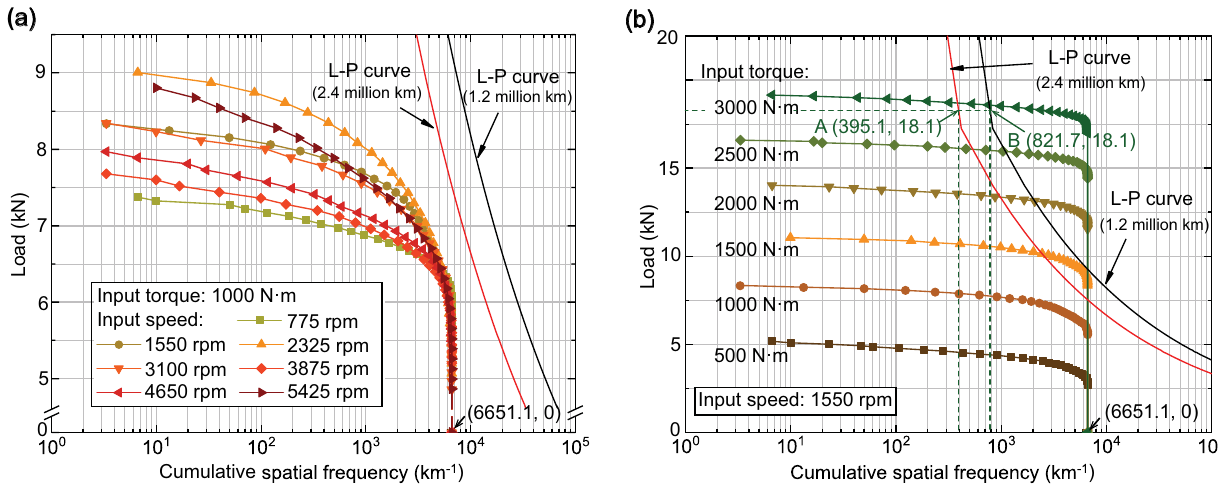
Fig. 14 Measured cumulative frequency amplitude spectrum of the bearing load under different gear meshing conditions of a different speeds and b different